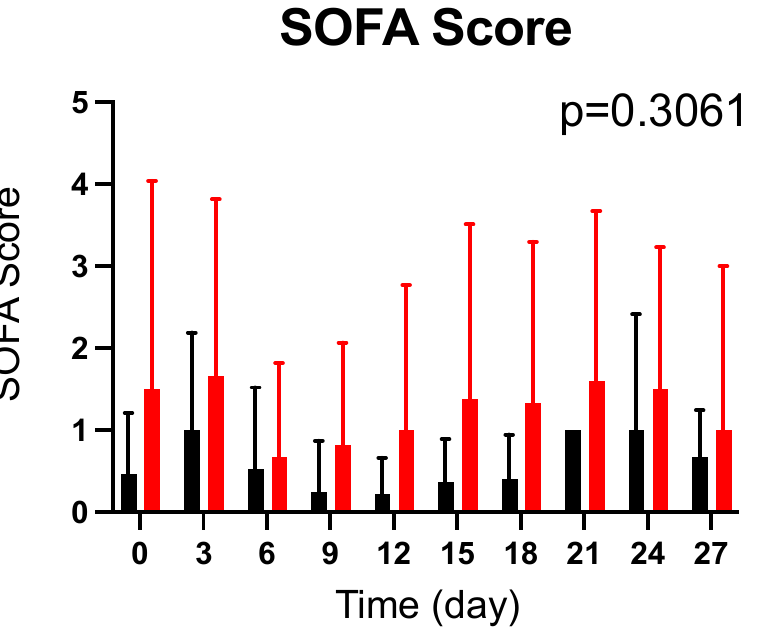
Figure 6. Effects of CoQ10 supplementation on SOFA score in burn patients. There was no significant difference in SOFA scores between the groups. The p value in the figure indicates overall difference between the groups across the different time points that was analyzed by a longitudinal general linear mixed-effects model. Black bar: Placebo, Red bar: CoQ10.